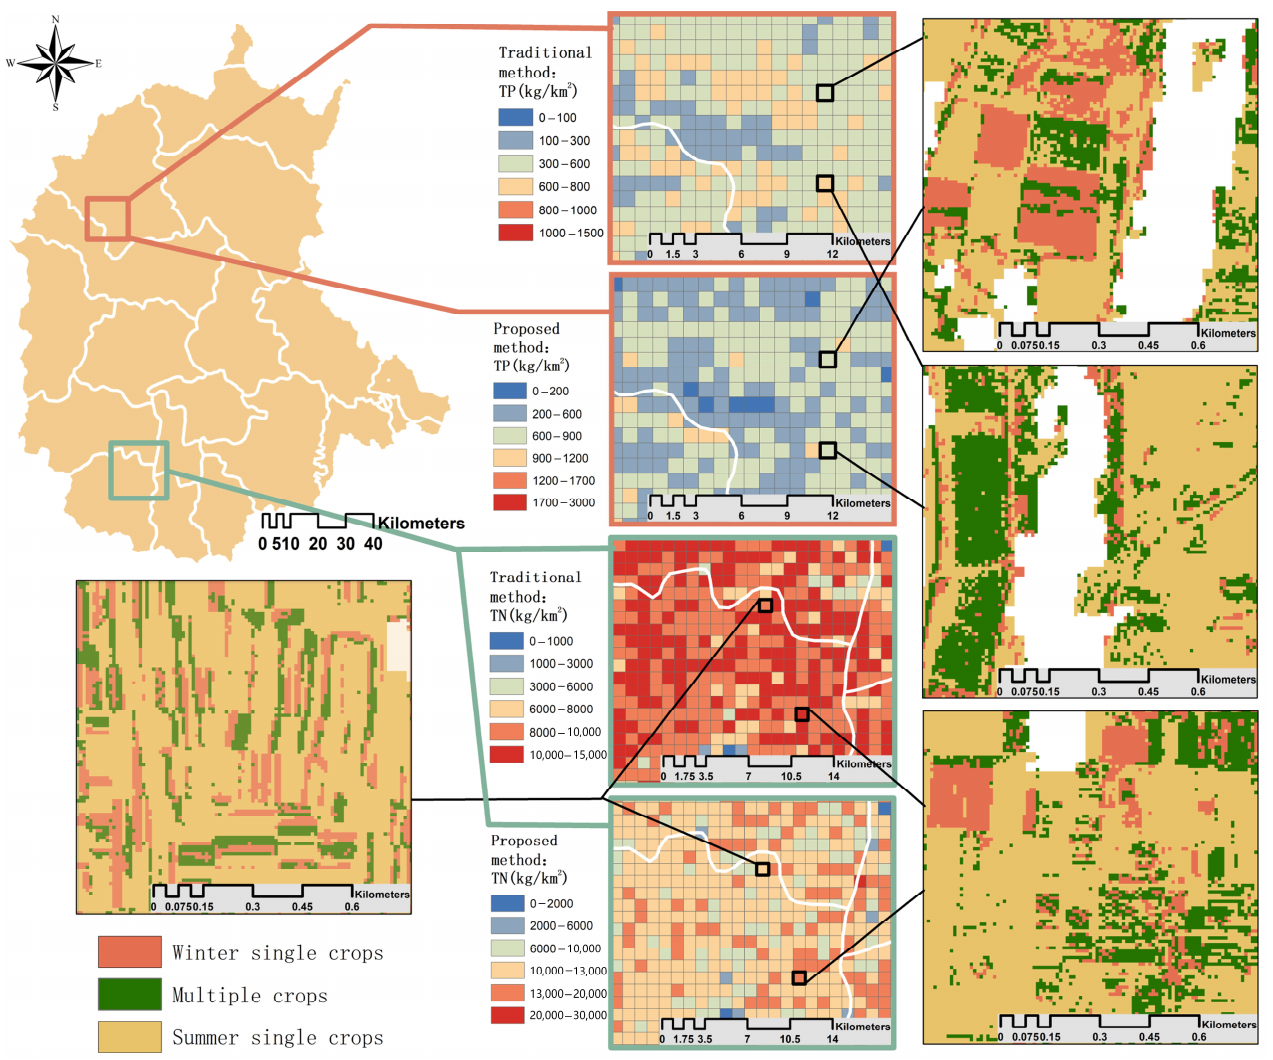
Figure 13. Comparison of the areas in red and green squares demonstrates that the distributions of results calculated by the traditional and proposed method are obviously different. The values of the same grid position are also different. There are various crops in the same grid, but they are generally classified into one category by traditional method, resulting in NSP estimation errors (the grids are the NSP intensity calculation cells, and their dimension is 1 km 2